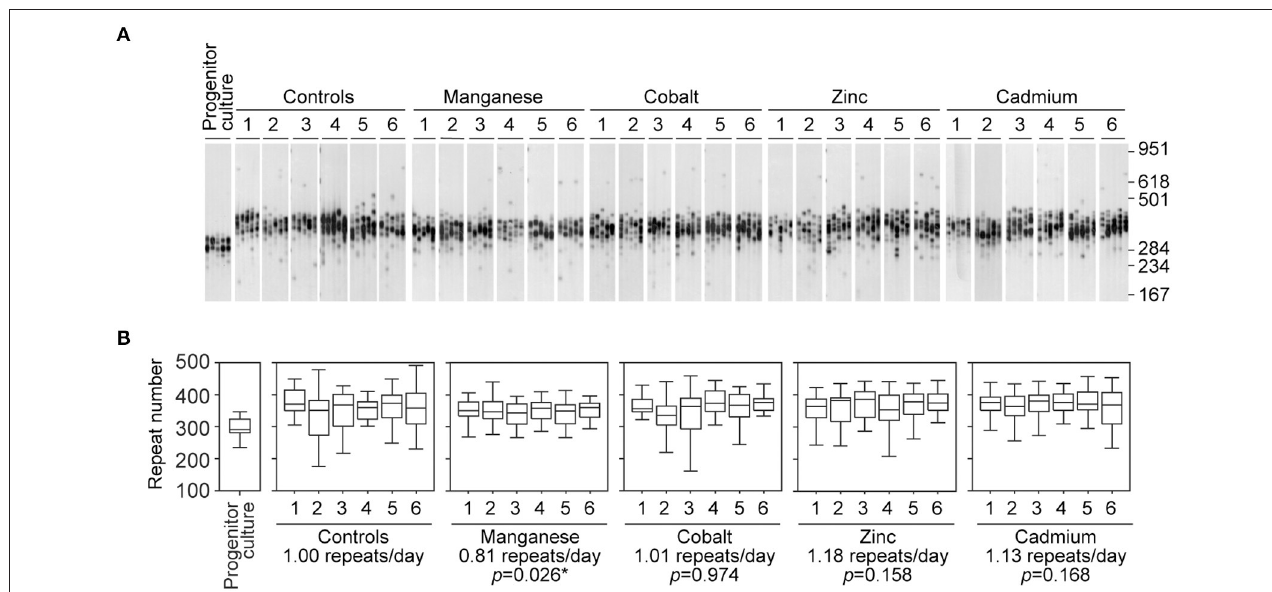
Change in median expansion rate (relative to controls)